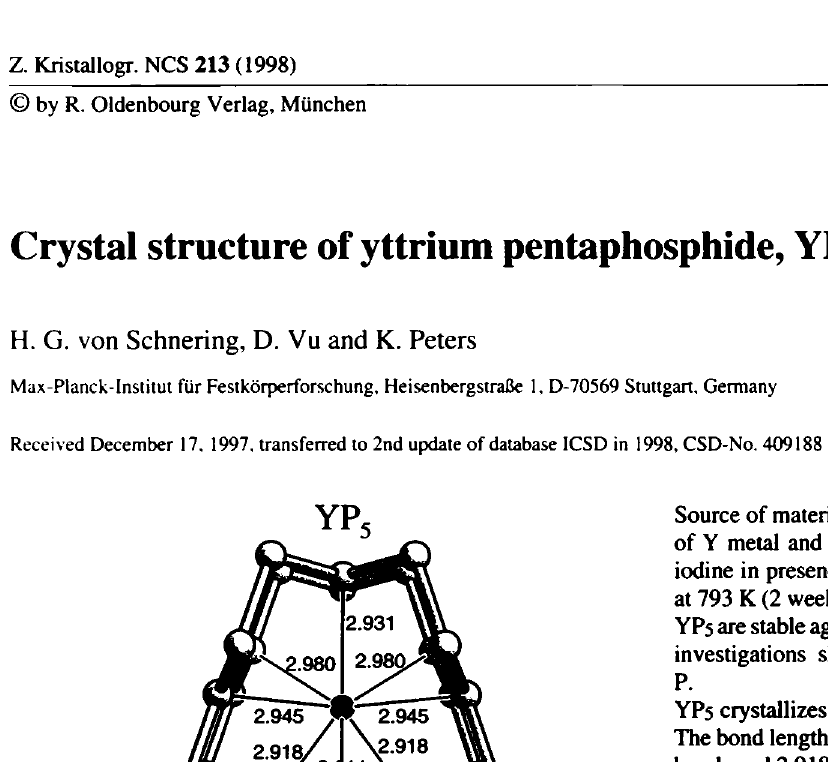
Table 1. Parameters used for the X-ray data collection Crystal: